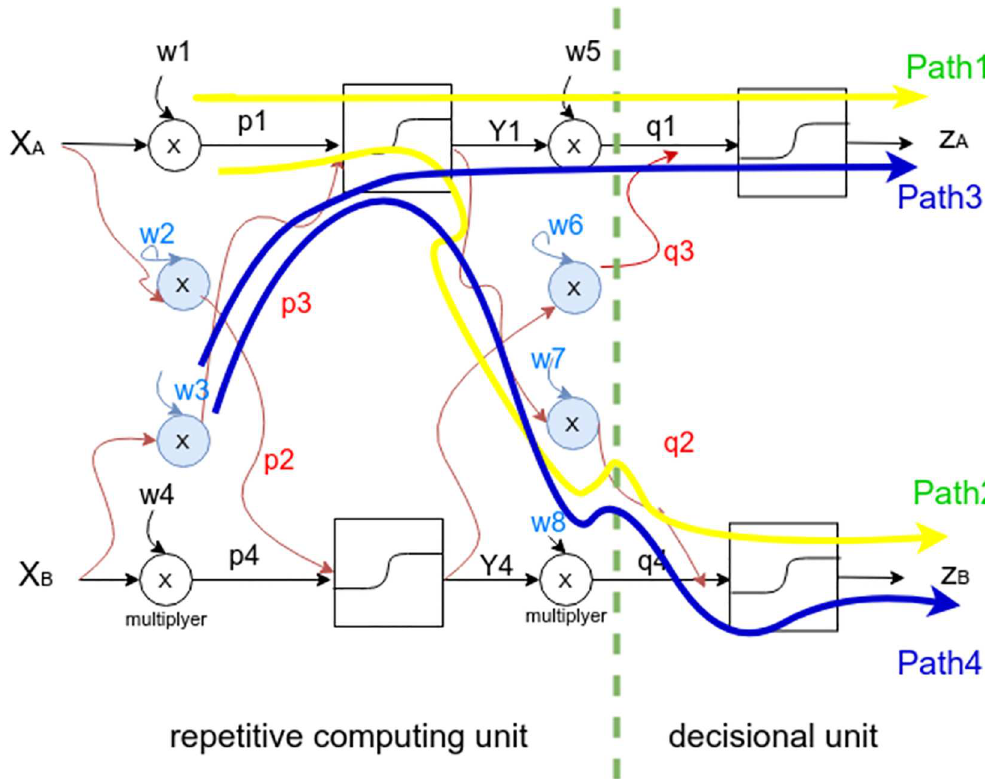
Fig 12. Two hidden layer DNN